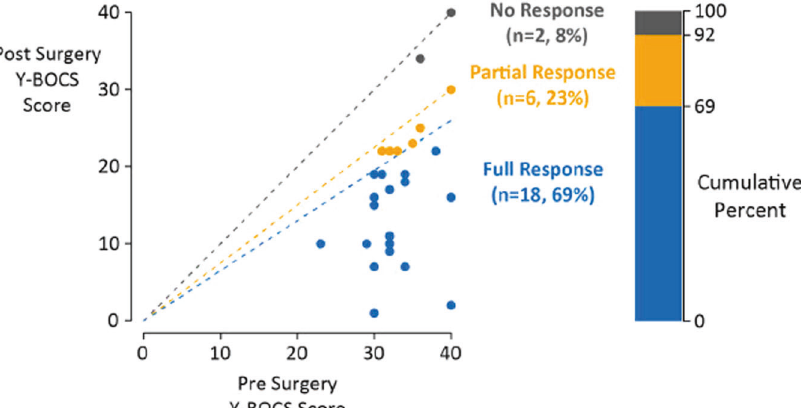
Fig. 2 Change in Y-BOCS scores following surgery. Each point shows a single patient ’ s pre-treatment ( x -axis) and post-treatment ( y -axis) Y-BOCS scores. Dashed lines show cutoffs for clinical categories: full response (35% reduction; blue), partial response (at least 25% reduction; yellow), and no response (<25% reduction; black). The inset stacked bars provide cumulative percentages of each